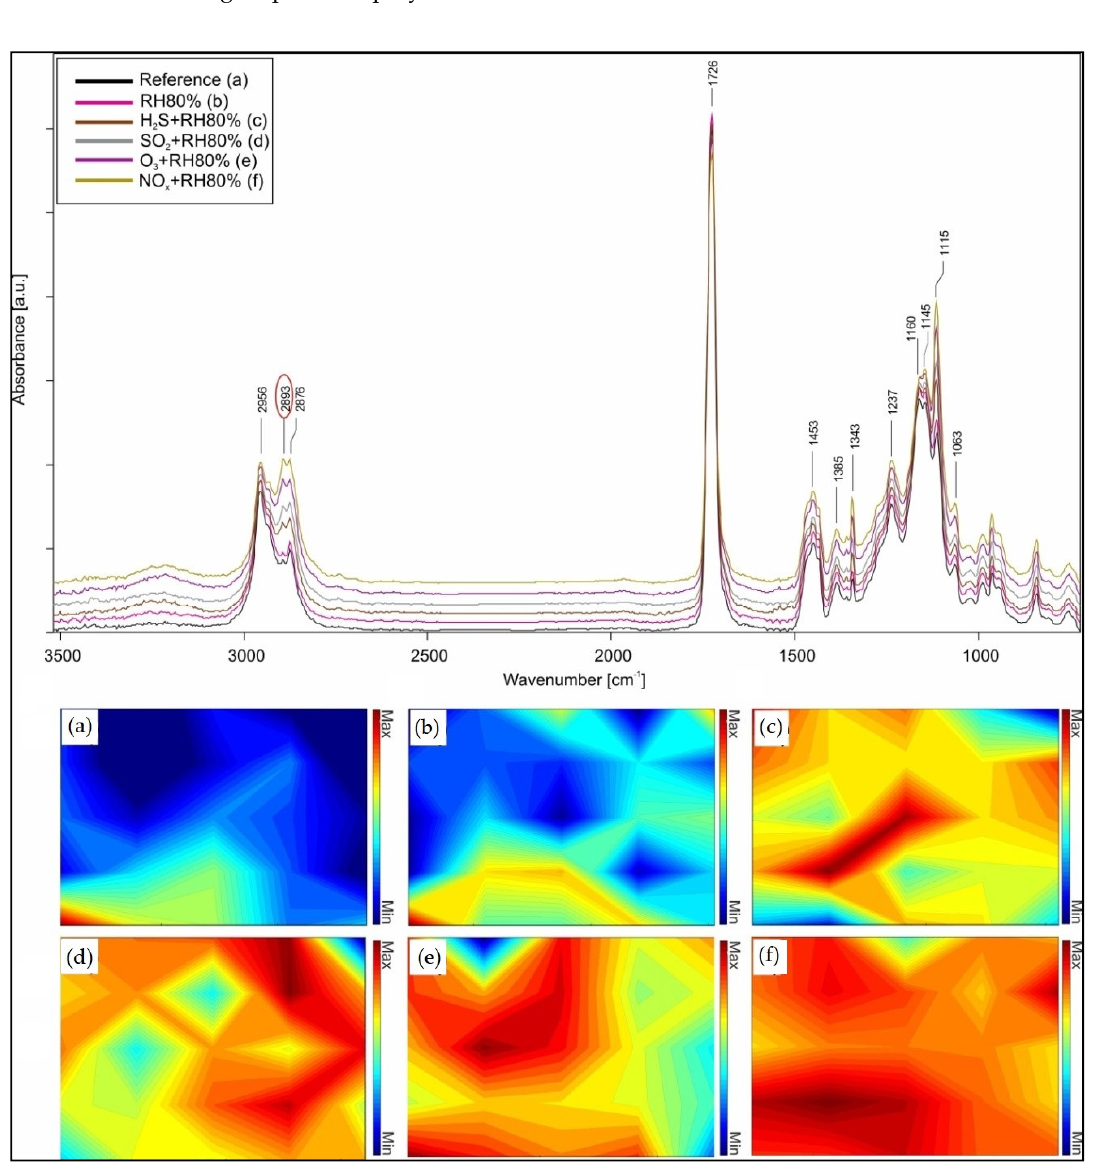
Figure 5. ATR-FTIR spectra and chemical mapping of the surfactant absorbance band integration at 2895 cm − 1 : ( a ) before aging and after ( b ) RH 80%, ( c ) H 2 S + RH 80%, ( d ) SO 2 + RH 80%, ( e ) O 3 + RH 80%, and ( f ) NO x + RH